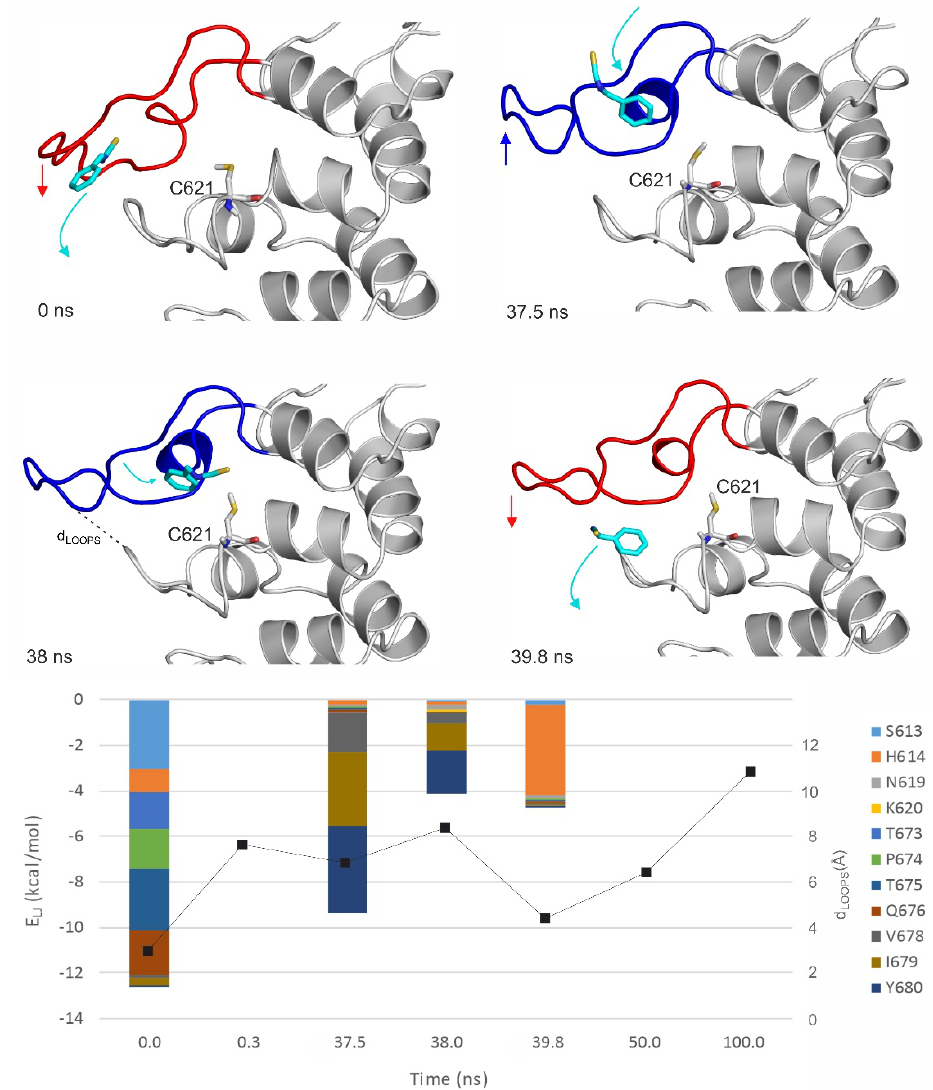
Figure 5. The MD rank1 simulation starting from the top 1st docked prerequisite binding mode of BITC on the apo TRPA1. Interaction energy distribution of the interacting amino acids of the outer prerequisite site are shown during the MD simulation. The loop motion is quantified by the distances between the N atom of N615 of the A-loop and O atom of Q676 of the opposite loop (black dotted line on the t = 38 ns structural plot, d LOOPS ) shown as joint black boxes. The structural figures are snapshots of the binding position of BITC at the stated time frame of the MD simulation. The protein is shown in grey cartoon and BITC with teal sticks. The A-loop is marked with blue and red in open and closed conformations, respectively. C621 amino acid is also shown as all atom sticks representation. The red and blue arrows show the movement of the A-loop and the teal arrows the movement of BITC. Lennard–Jones interaction energies calculated between BITC and the TRPA1 target amino acids are shown per residue on the diagram.